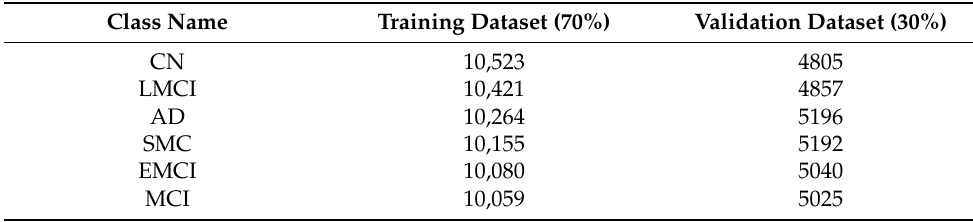
Table 5. Details of the dataset split for training and validation.